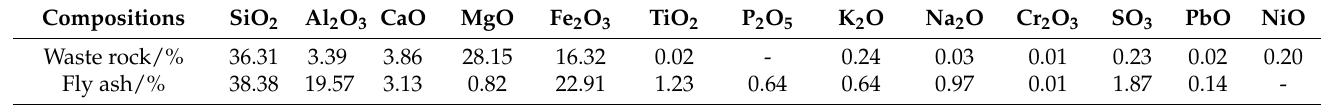
Table 1. Main chemical compositions of the waste rock and fly